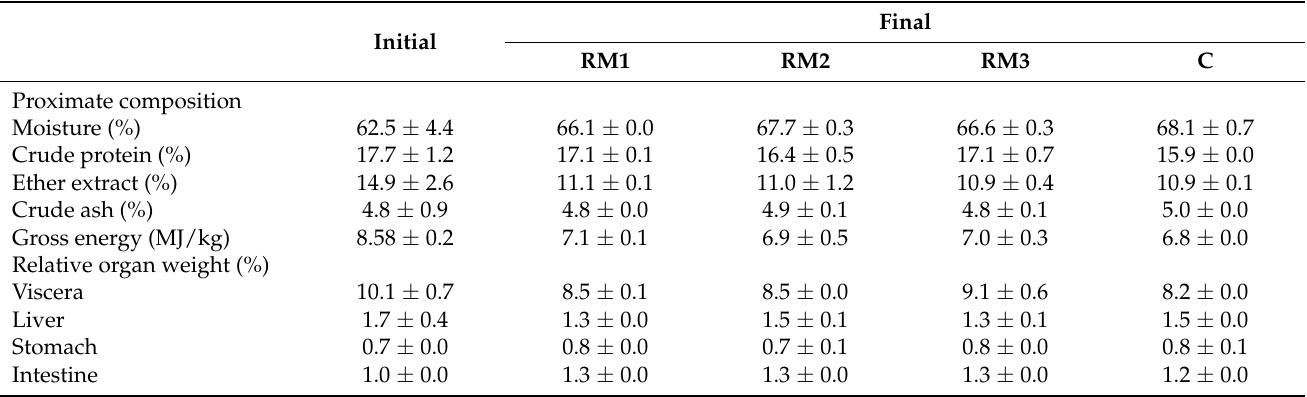
Table 11. Whole body proximate composition and relative organ weight in fish fed the experimental diets in Trial 3.